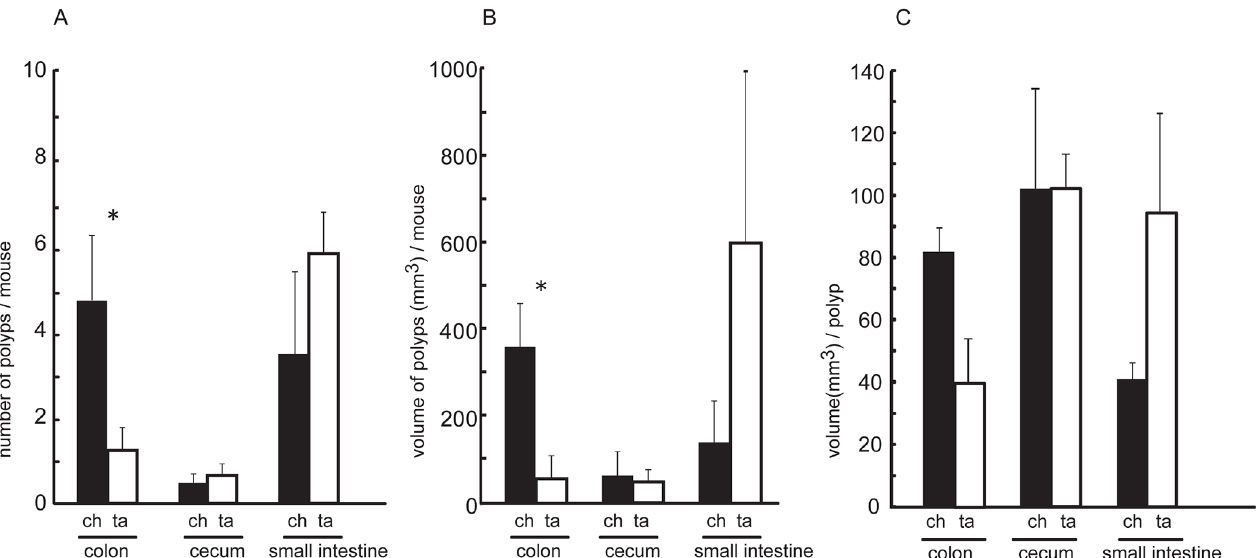
Fig 2. Polyp number and volume in the colon, cecum, and small intestine. A greater number of polyps was detected in the colon than in the ileum of the chlorinated water group (black columns), whereas more polyps occurred in the small intestine in the tap water group (white columns). Polyp volume was correlated with polyp number, and colon polyp volume differed significantly between the two groups. ch; chlorinated water group, ta; tap water group. * P < 0.05 (Student ’ s t test).